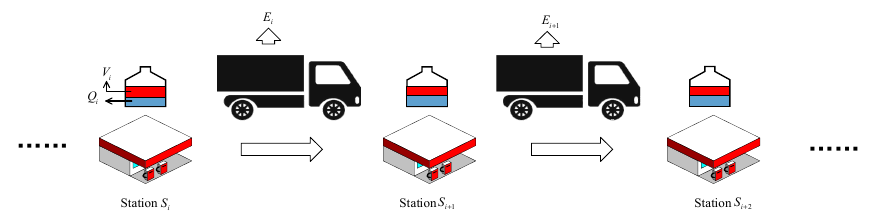
Figure 2. Refueling behavior diagram.